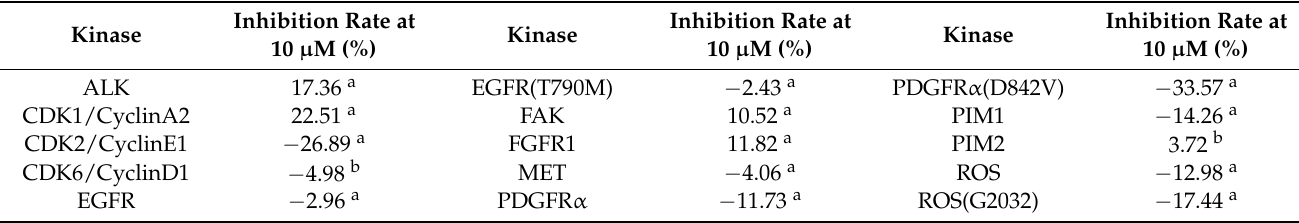
Table 2. Selectivity profiling of compound 3a against a panel of tyrosine